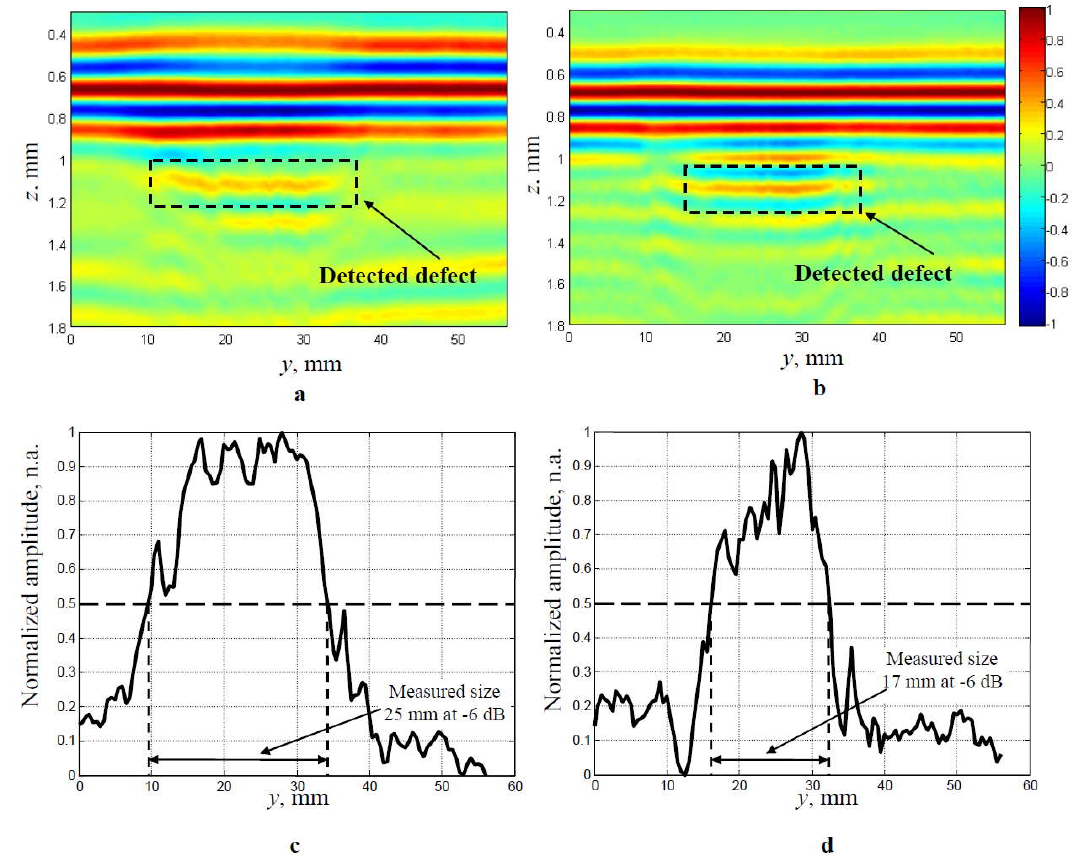
Figure 9. Experimentally obtained B-scan images ( a , b ) and the normalized peak amplitudes ( c , d ) of the delamination type defect of 25 mm detected in the multi-layered GLARE sample by a dual focused beam in the elevation and azimuth cross-sections ( a , c ) and focusing in the azimuth cross-section (without a lens) only ( b , d ).